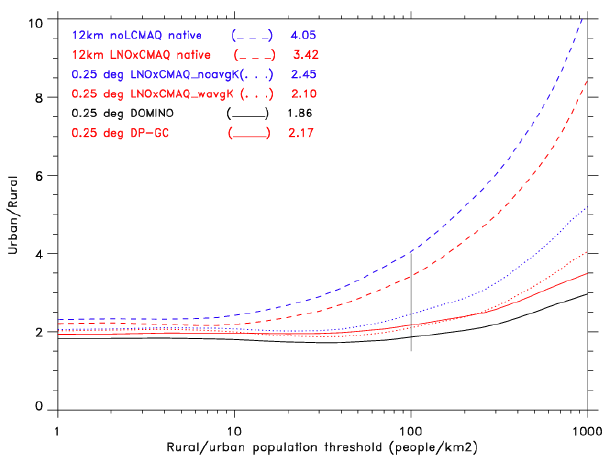
Figure 7. Ratio between mean urban and rural tropospheric NO 2 columns as a function of the population threshold (people km -2 ) used to separate rural and urban grid boxes. The solid black (red) line shows the ratio calculated from the gridded 0.25°x0.25° DOMINO (DP-GC) product. The dashed blue (red) line shows the ratio based on 12-km CMAQ output from simulation noL (LNO x ). The dotted blue (red) line shows the ratio based on CMAQ simulation LNO x output without (with) application of the averaging kernel.